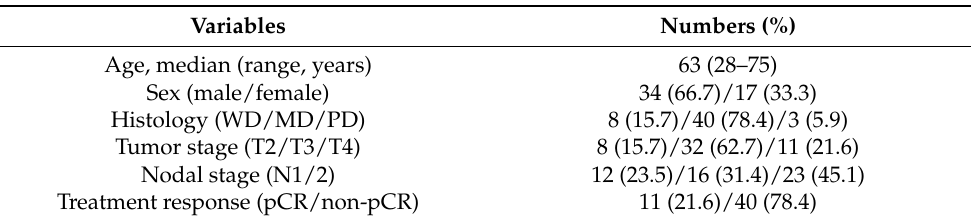
Table 1. Clinicopathologic Characteristics of the 51 Rectal Cancer Patients Receiving Chemoradio-